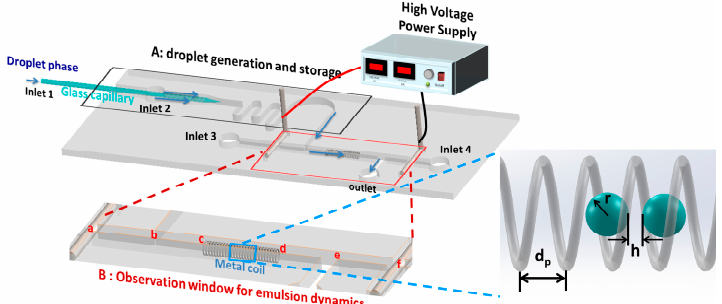
Figure 1. The schematic of the experimental device. ( A ) Droplet generation and storage; ( B ) The observation window for studying the emulsion dynamics in an electric field. There are two electrodes on the left and right sides of the observation channel, which are referred to as “a” and “f” in the schematic. Droplets flow from inlet “b” into the observation channel and then leave from outlet “e”. A metallic coil is inserted inside the middle of channel from “c” to “d”. A high voltage is applied to the device by connecting the electrodes to a power supply. d p is the distance between each pitch of the coil; r is the radius of droplets; h is the distance between two droplets.